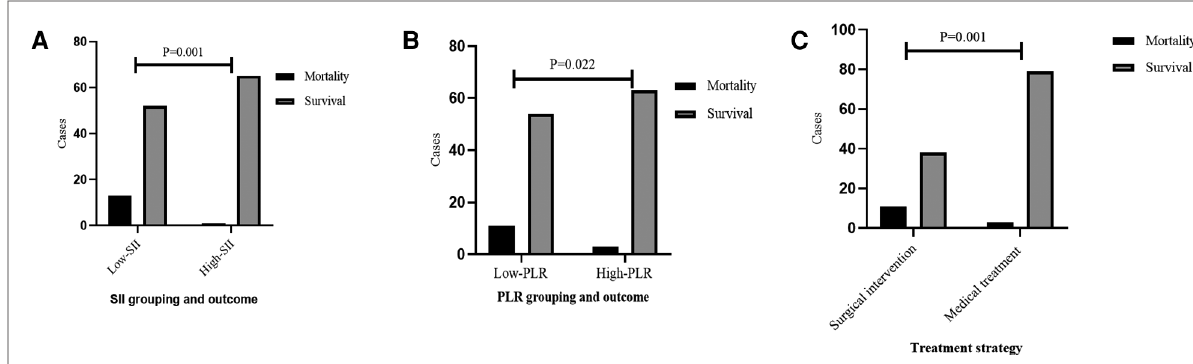
FIGURE 6 The number of patients who died and survived in different subgroups.